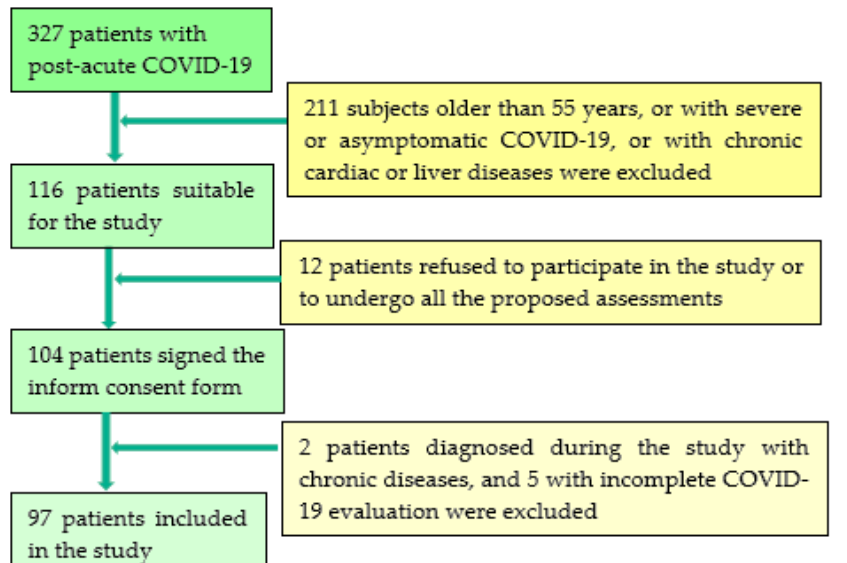
Figure 1. Timeline of study population selection.